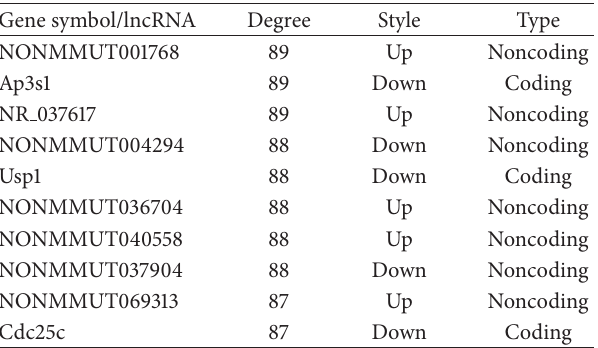
Table 3: Part of lncRNAs and mRNAs owned the biggest degree in cytokine stimulation group.